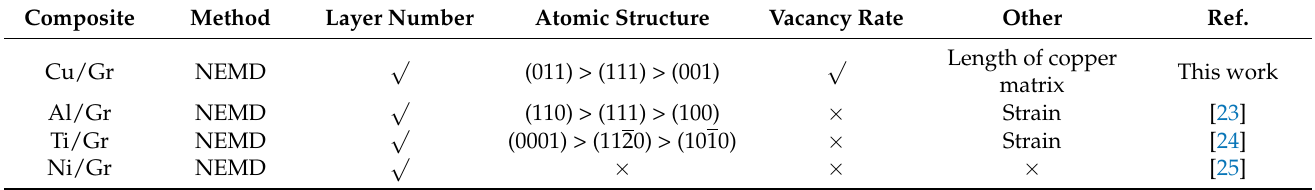
Table 1. The studies of different metal matrix/graphene composites using NEMD